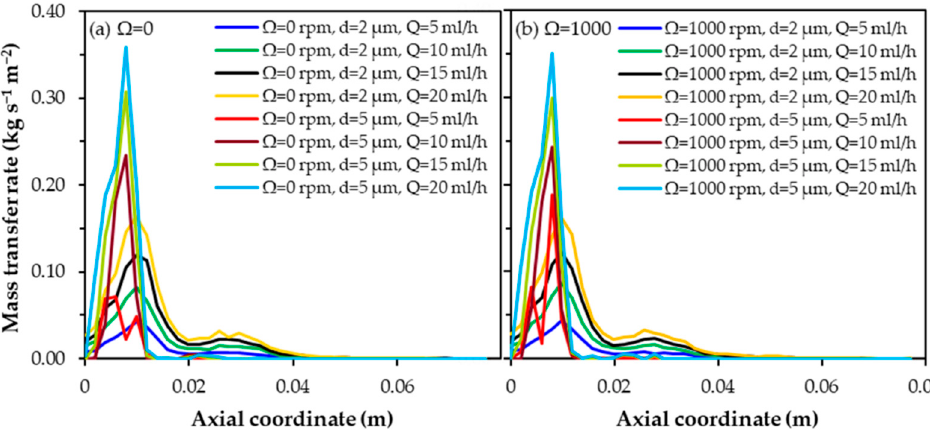
Figure 9. Mass transfer rate from the Lagrangian phase to the Eulerian wall film as a function of the channel axial coordinate: each curve corresponds to a specific combination of the values of the drill bit rotational speed Ω , oil droplet diameter d at the channel inlet, oil flow rate Q.